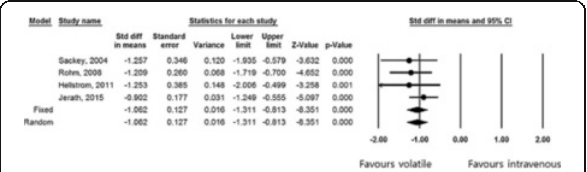
Fig. 64 (abstract A146). Forest plot of extubation time